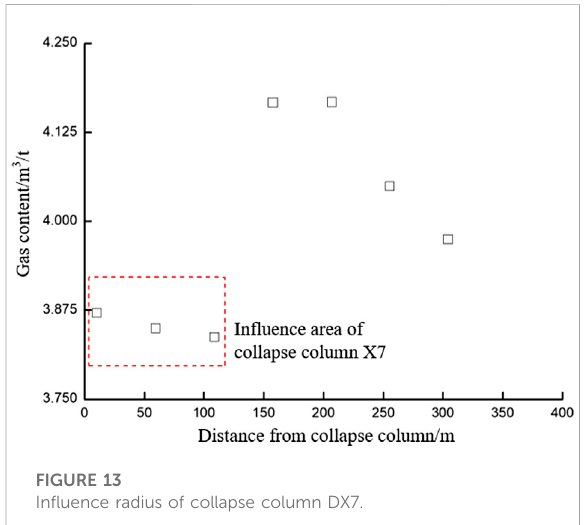
FIGURE 13 In fl uence radius of collapse column DX7.